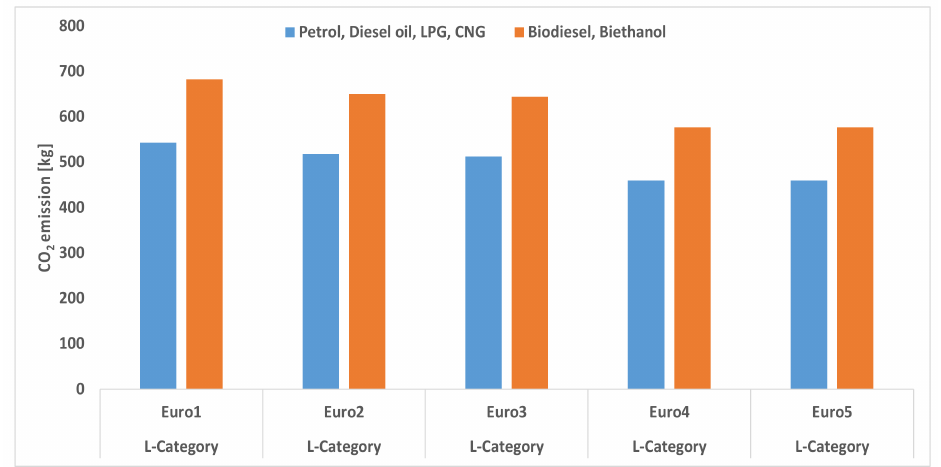
Figure 7. Comparison of CO 2 emissions from L-category vehicles and buses depending on Euro standard and fuel